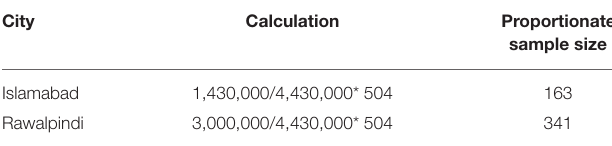
TABLE 3 | Dimensions of the